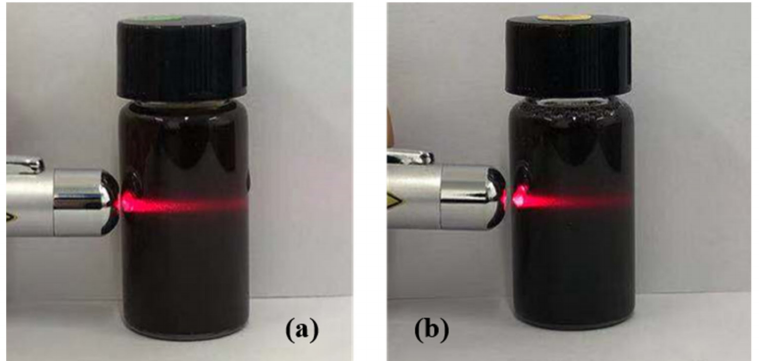
Figure 5. Characterization of aqueous dispersion of GO and PSG: ( a ) GO; and ( b ) PSG.